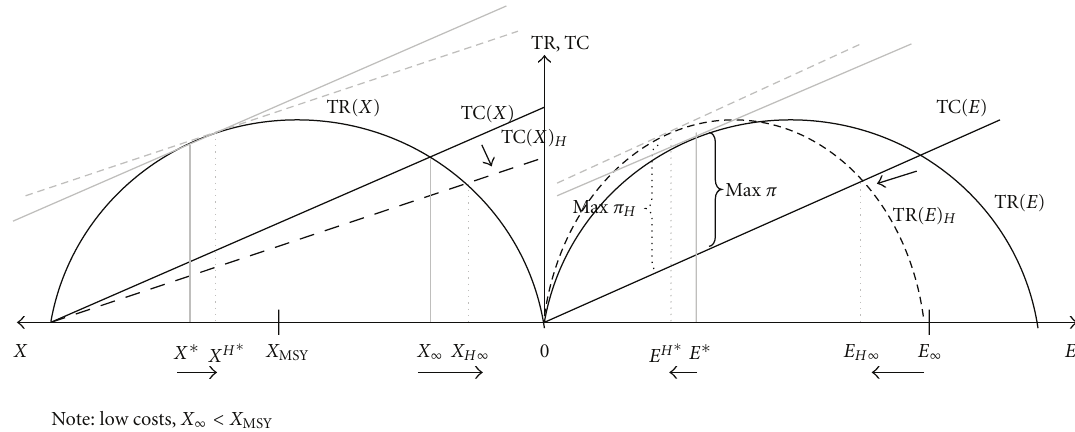
Figure 3: The e ff ect of habitat via the catchability on TR, TC, and equilibrium solutions under open access and maximum economic yield (MEY) when unit costs of e ff ort are low.